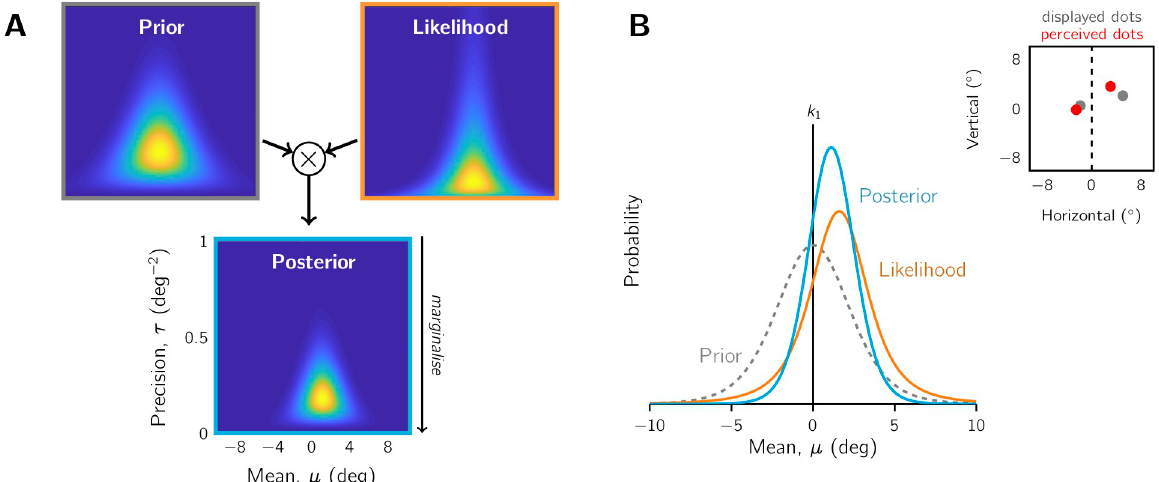
Fig 6. Elements of the decision models. Depicted is the estimated joint probability of the dot-cloud generating distribution mean and precision for an example stimulus presentation of 2 dots. A) Centred Normal-gamma prior distribution (based on the stimulus statistics of the experiment), likelihood function based on the noisy dot observations, and the resulting normal-gamma posterior distribution. All three distributions have the same axes as the ones shown in the posterior panel. B) The marginal prior (grey), likelihood (orange), and posterior (blue) for estimating the generating distribution mean. An unbiased Type 1 decision criterion, k 1 , is also depicted. Inset: the displayed and perceived locations of the two sampled dots, with the dashed line indicating the screen midline.